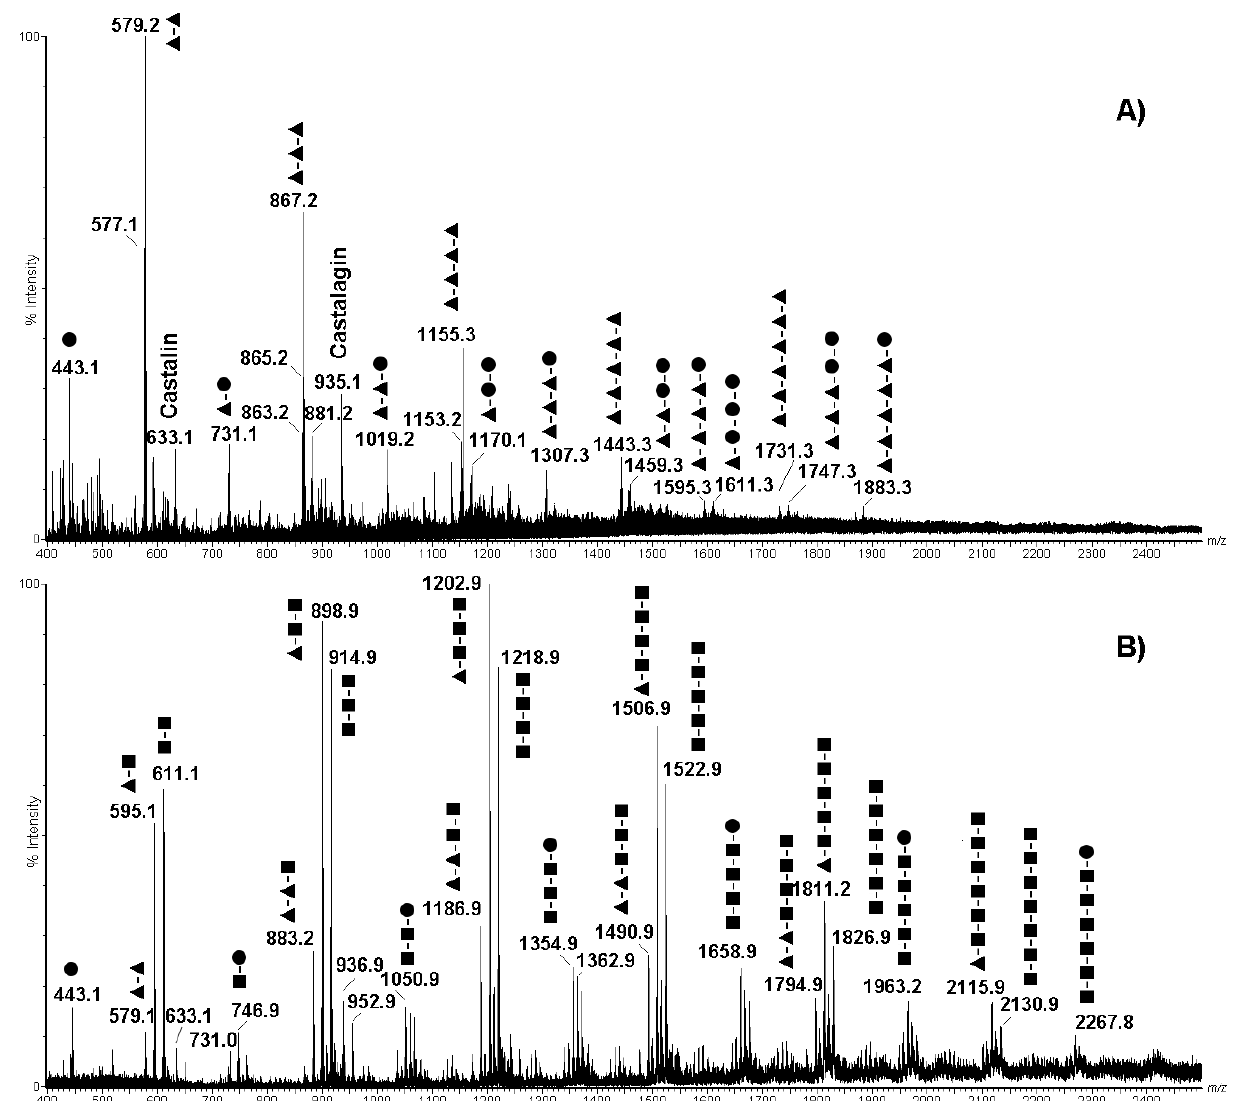
Figure 3. ESI-qTOF mass spectra of extracts from chestnut pericarp (panel ( A )) and integument (panel ( B )) tissues acquired in positive ion mode. In panel ( A ), assigned are procyanidins non-galloylated and mono-galloylated oligomers; in panel ( B ), labeled are epigallocatechin and epicatechin gallate oligomers. ▲ , epicatechin; , epigallocatechin; ● , epicatechin gallate.